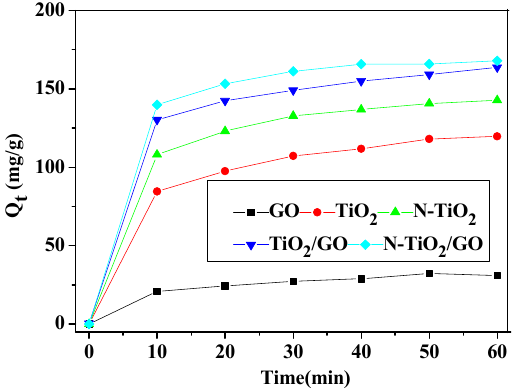
Figure 7. RhB adsorption by different samples.